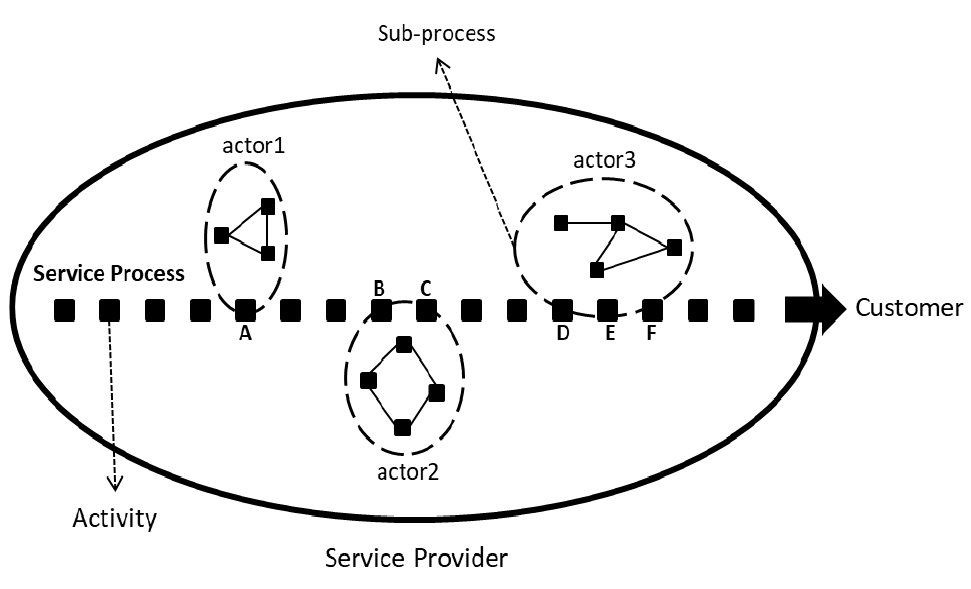
Figure 5. Granularity of value.